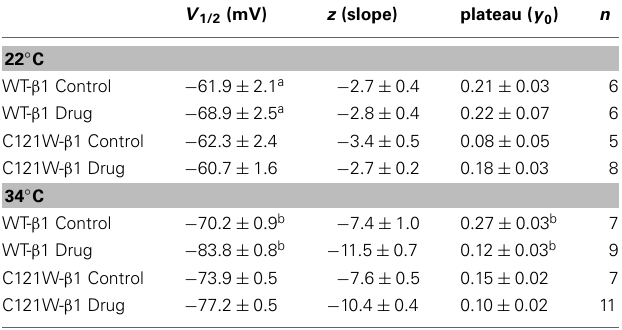
FIGURE 5 | Steady-state slow inactivation. Normalized Current is plotted against the potential (mV). Control is shown in black circles and drug in red triangles. For both WT at 22 ◦ C and 34 ◦ C (A,B) and C121W at 22 ◦ C and 34 ◦ C (C,D) . Panel (D) shows an inset of the pulse protocol used to measure slow Table 6 | Steady-state slow